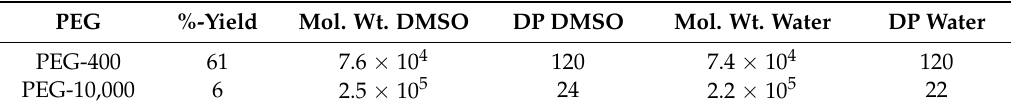
Table 1. Sample results for the synthesis of water-soluble polyethers from reaction of dibutyltin dichloride with PEG. The specific reaction conditions are dibutyltin dichloride (3.00 mmole) in 30 mL heptane added to rapidly (18,000 rpm; no-load) stirred aqueous solutions (30 mL) containing diol (3.00 mmole) and sodium hydroxide (6.0 mmole) with stirring for 15 s (DMSO: dimethyl sulfoxide; DP: degree of